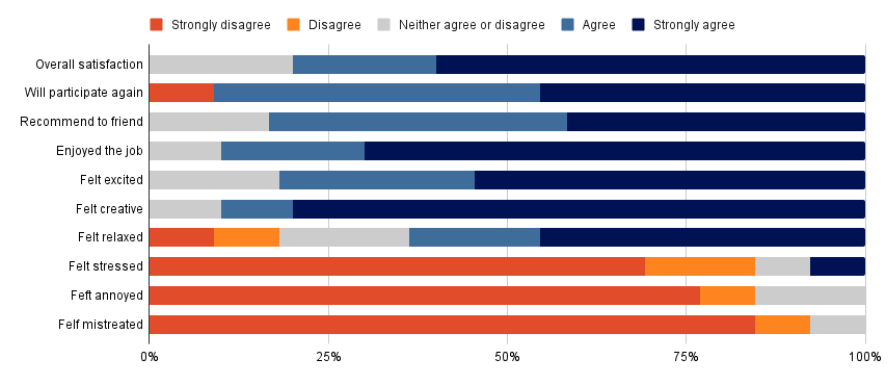
Figure 7. Architects survey results revealing the satisfaction of freelance architects with performing the various